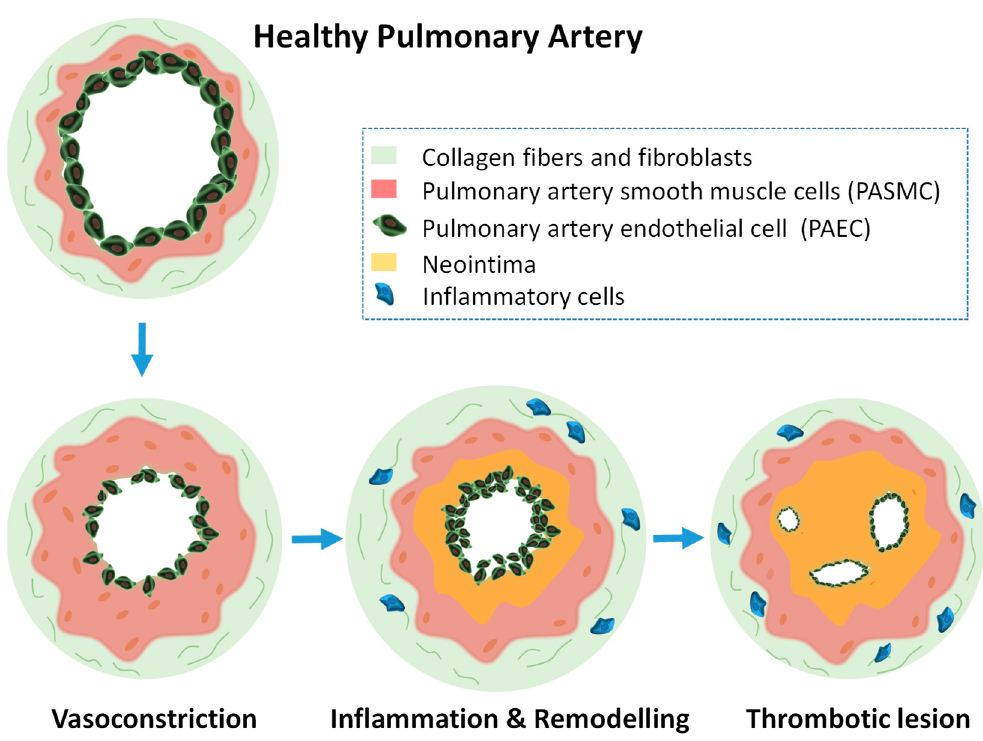
Figure 4. Schematic drawing of a transversal section of a pulmonary artery developing PH and the structural alterations in the different cellular levels. Initially smooth muscle cells excessively proliferate producing vasoconstriction. After that, inflammation, remodeling, and thrombotic lesions will follow. Currently, PH treatments only help to relieve the symptomatology and do not stop the progression of the disease. The medical therapies available for the treatment of PAH include calcium channel blockers, endothelin receptor antagonists, phosphodiesterase type 5 inhibitors and soluble guanylate cyclase stimulators, prostacyclin analogues, and prostacyclin receptor agonists